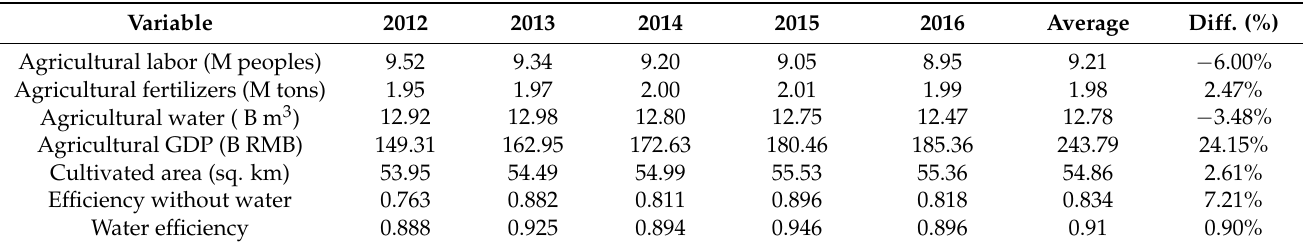
Table A3. Variables and average values and fluctuations in China’s agricultural efficiency for